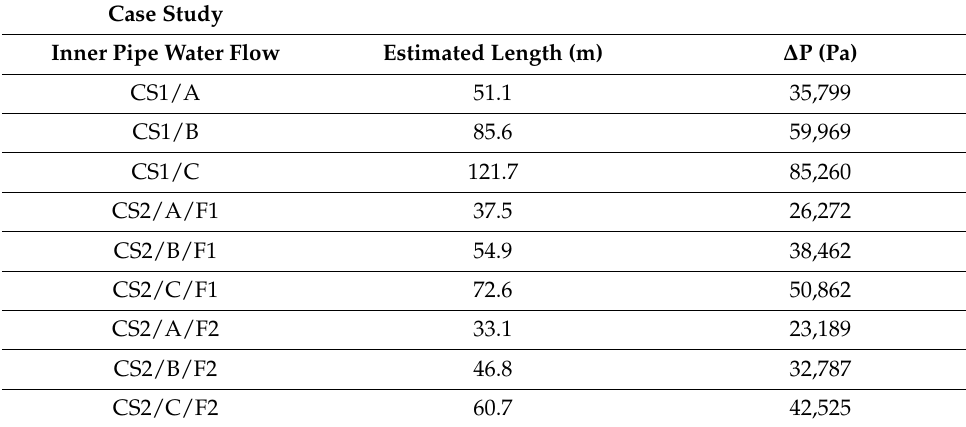
Table 8. Pressure drop per case study and